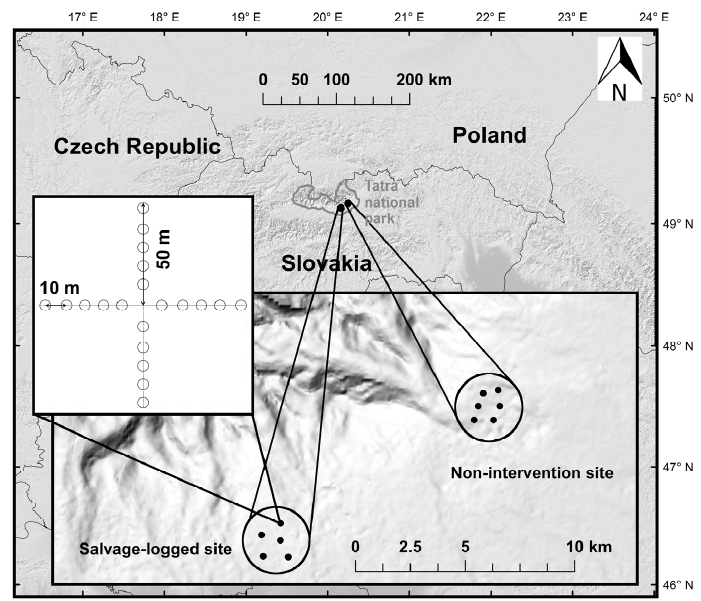
Figure 1. Sampling design: six and five experimental plots are located in the non-intervention and the salvage-logged sites found in the Tatra National Park (Slovakia), respectively. Each experimental plot is comprised of twenty circular subplots of r = 1 m (area: 3.14 m 2 ) that are arranged along two perpendicular transects.